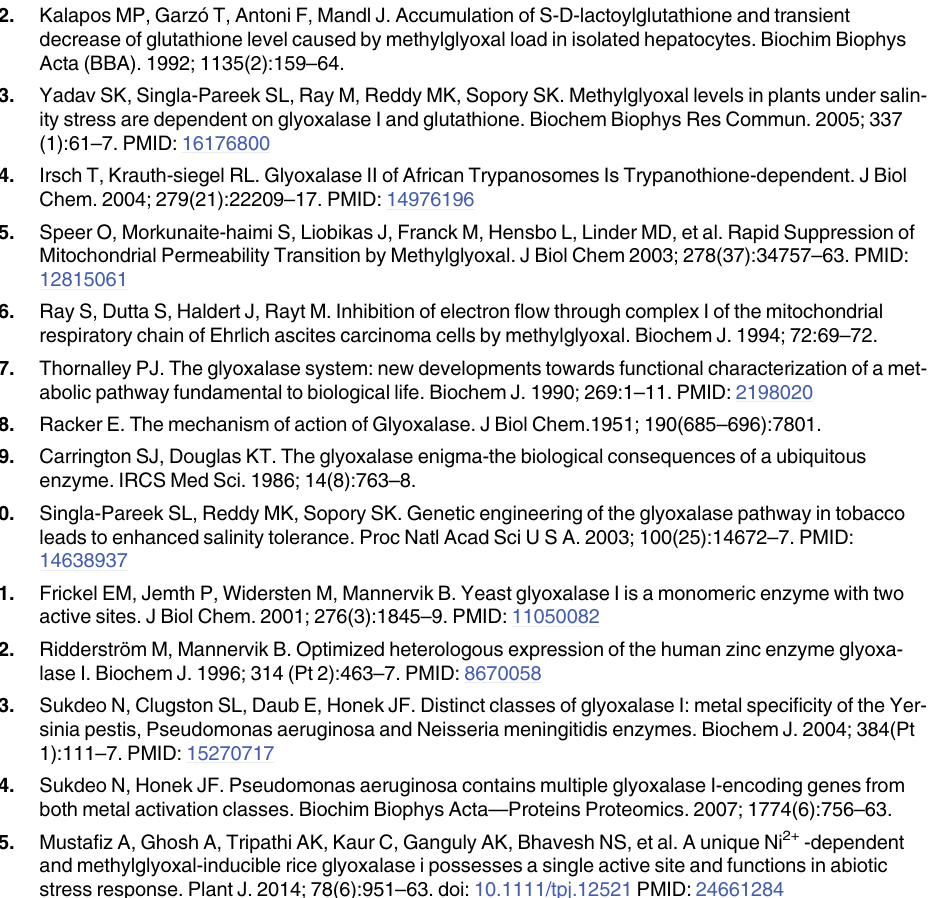
S1 Table. A list of putative active GLYI members identified in Arabidopsis. Each of the eleven GLYI protein sequences were analyzed using BLASTP search tool for the presence of various domains required for GLYI activity. AtGLYI2, AtGLYI3 and AtGLYI6 were found to possess all four important domains. (TIFF) S2 Table. A list of primers used in the study.